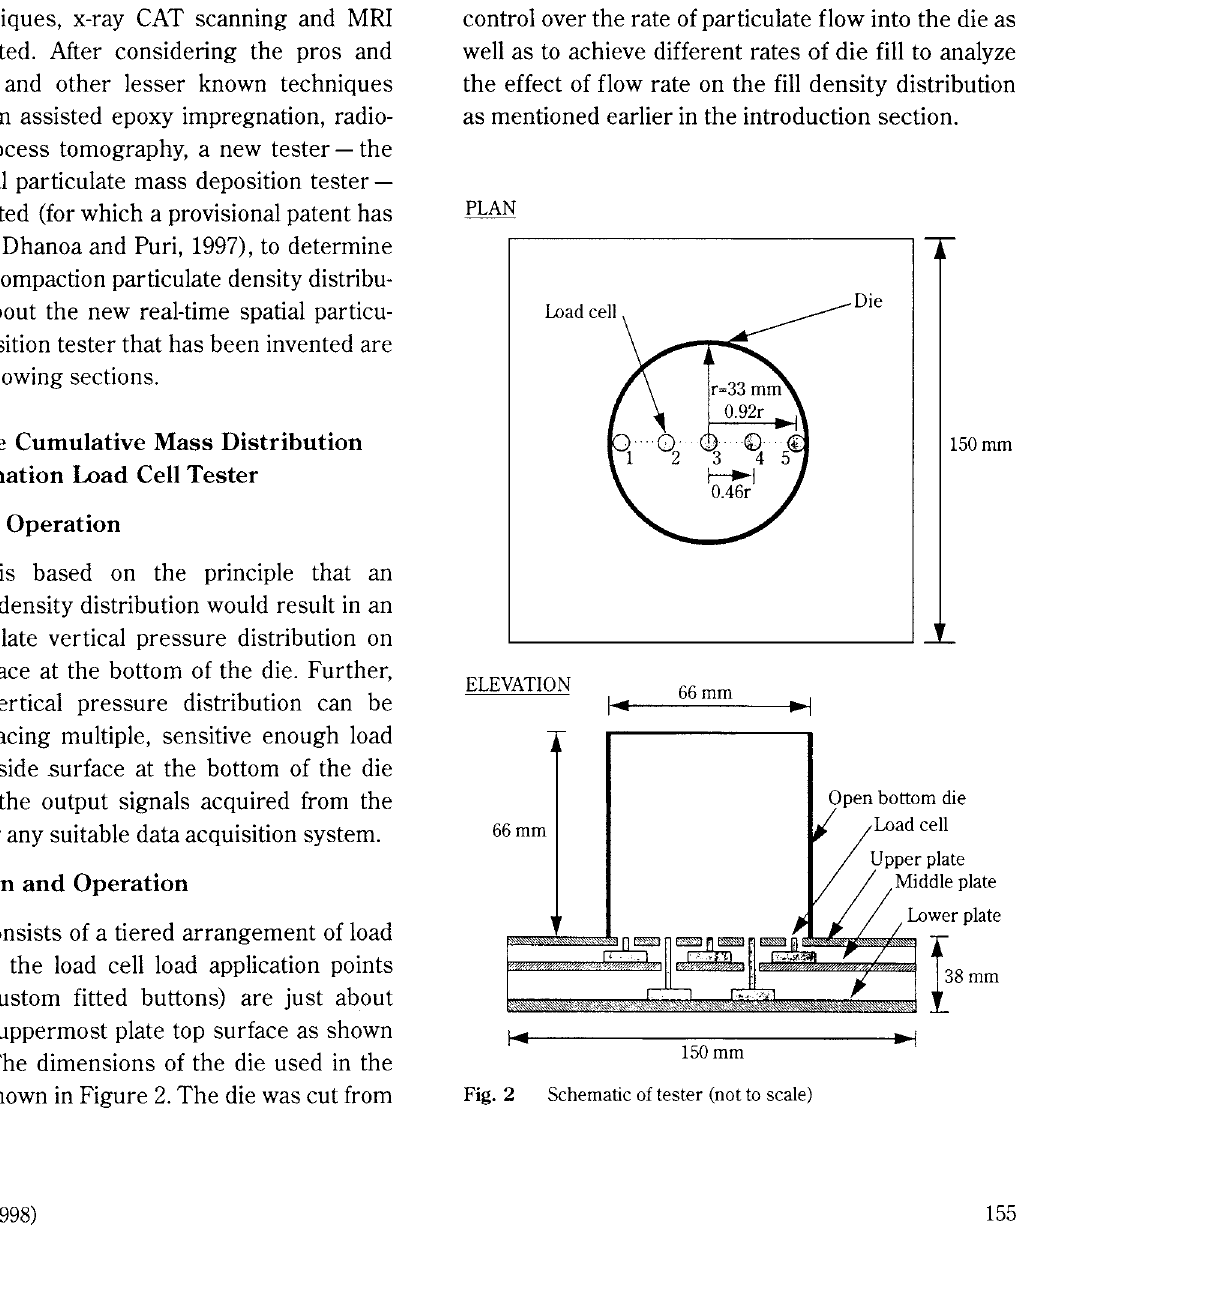
Schematic of tester (not to